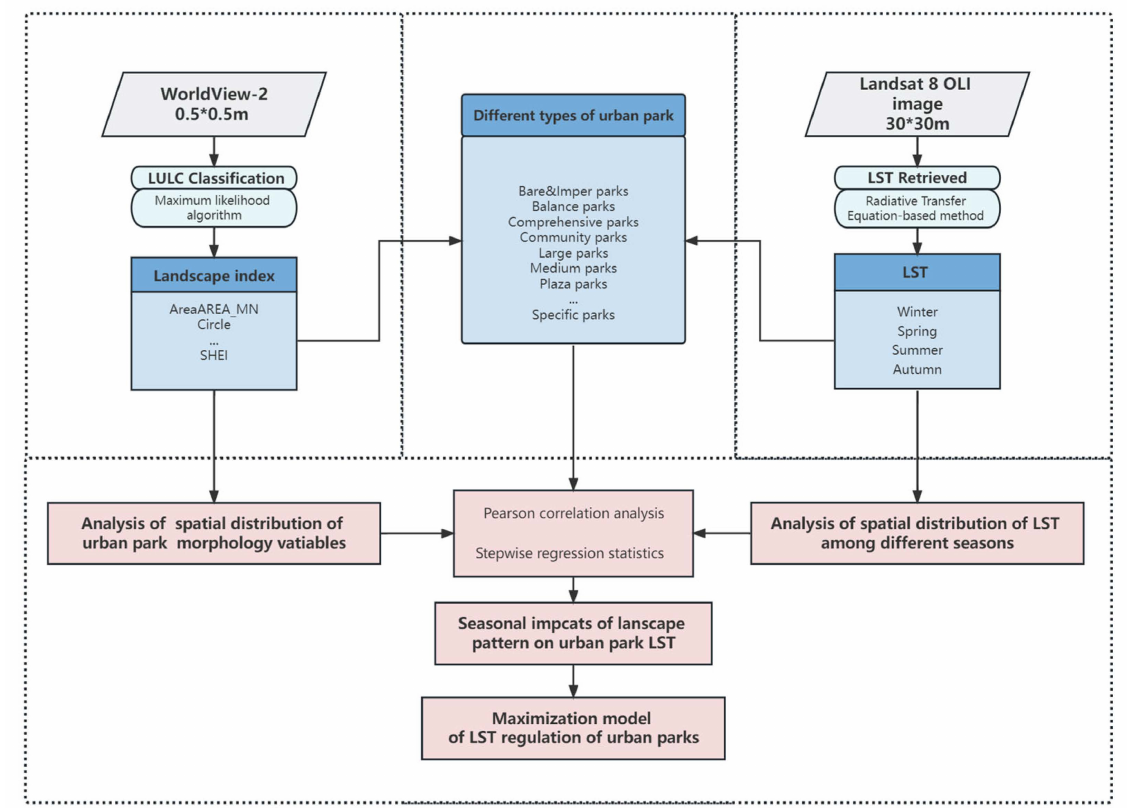
Figure 2. Flowchart of this